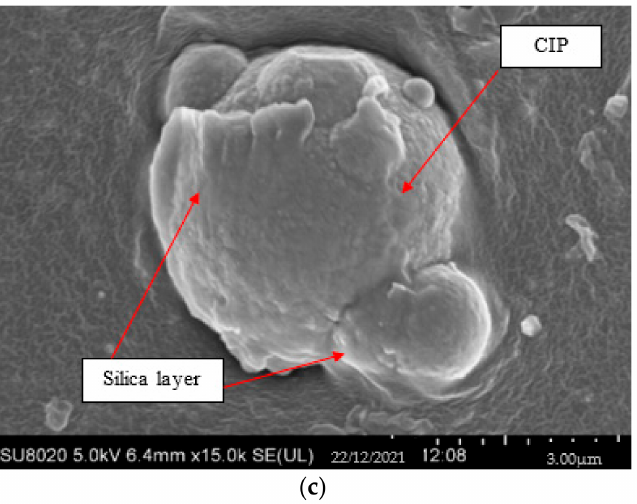
Figure 1. FESEM micrograph of EPDM-based MRE: ( a ) sample S1 (0 wt.% silica), sample S5 (11 wt.% silica) at ( b ) 1.5 k × and ( c ) 15 k × magnification.